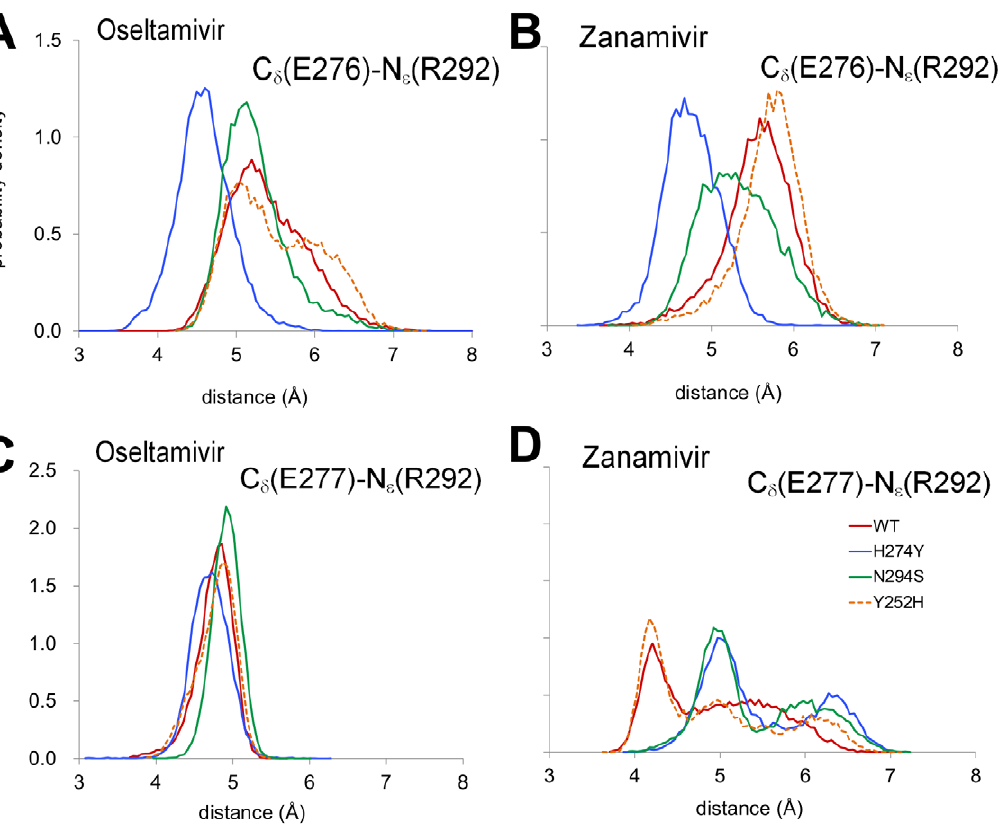
Figure 3. Comparison of WT and mutant dynamics. For WT and H274Y, N294S, and Y252H, distance distributions between the atoms C d of E276 and N e of R292 and between the atoms C d of E277 and N e of R292 are shown for oseltamivir ( A, C ) and zanamivir ( B, D ),